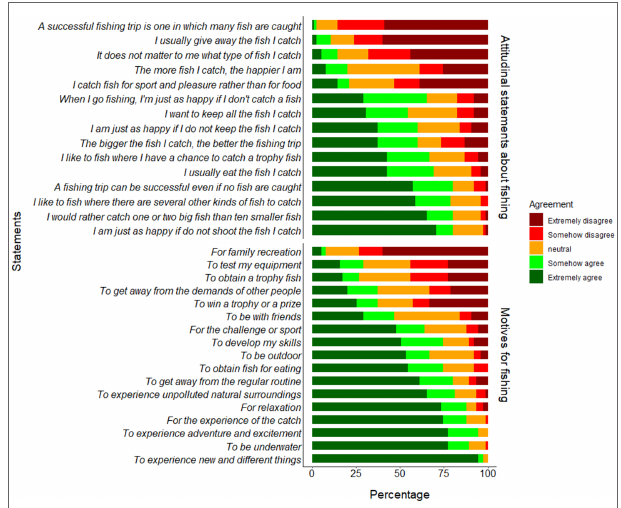
FIGURE 6 | The precision of spearfishers is calculated as the difference between the weight of fishes and the tournaments-specific minimum weight limits. Points represent the mean values for each species and the horizontal lines represent the standard error. The vertical dashed line represents 50 g (N between 1113 for D. sargus and 1 for T. ovatus and T. draco )